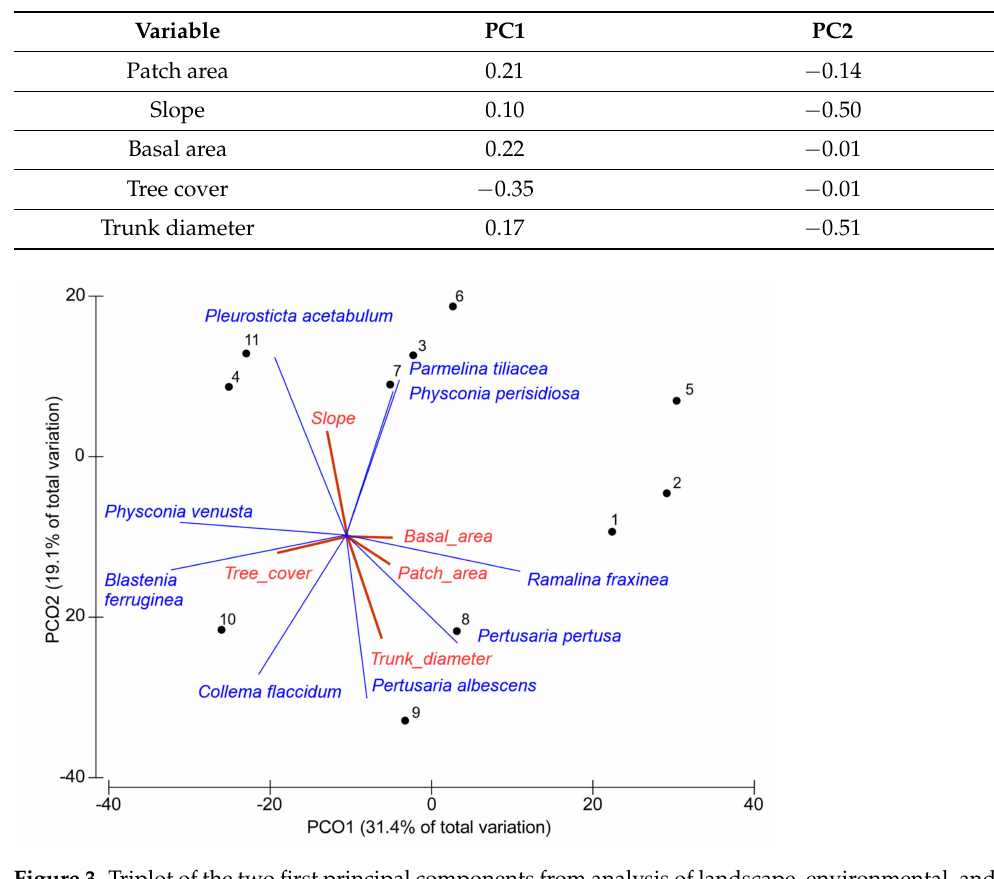
Figure 3. Triplot of the two first principal components from analysis of landscape, environmental, and forestry variables (patch area altitude, slope, aspect, basal area, cover tree layer, and trunk diameter). Only variables having Spearman’s correlation >0.2 are shown. Correlation’s threshold for lichen species was set at